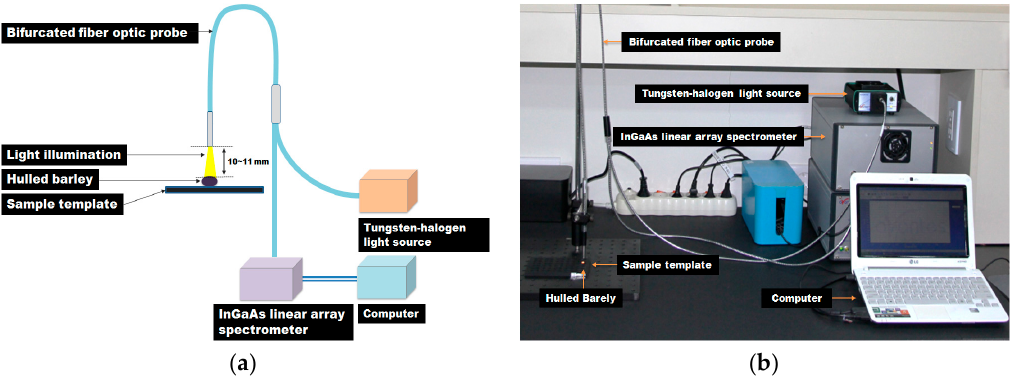
Figure 1. ( a ) Schematic diagram and ( b ) photo of the NIR measurement system for the discrimination of hulled barley infected with Fusarium.